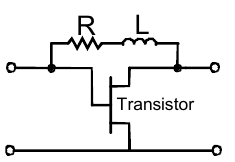
Figure 8: NGD circuit used ( R = 56 Ω and L = 220 nH).